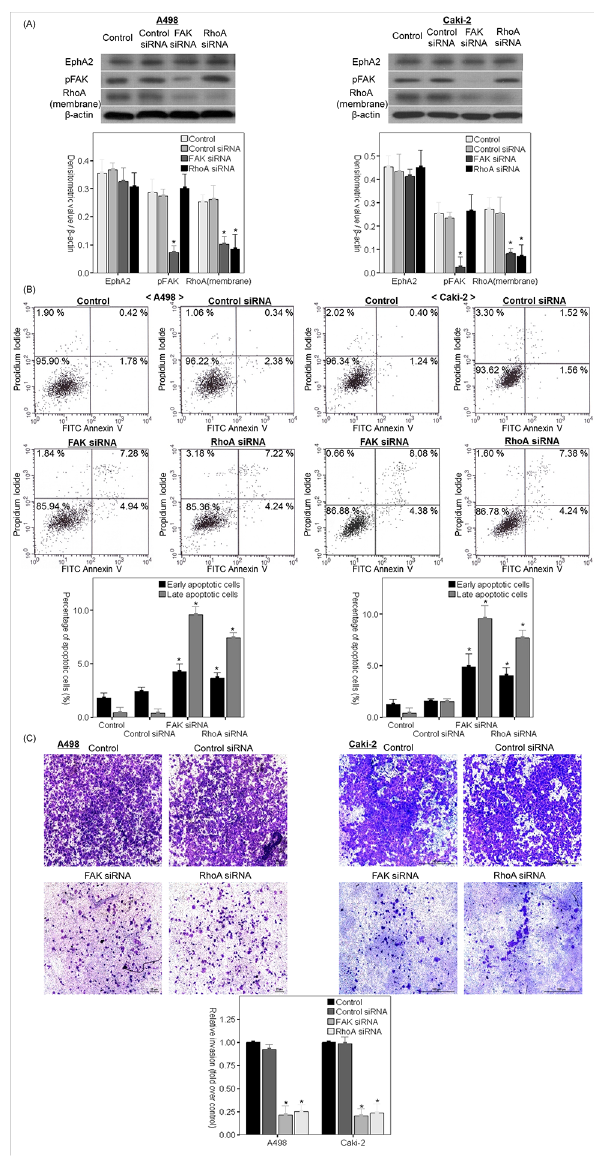
Fig 8. Effect of FAK/RhoA siRNA on malignant cellular behavior and EphA2 expression in non- metastatic RCC cells. (A) Representative immunoblots and comparisons of protein expression of EphA2, pFAK, membrane-bound RhoA and β -actin among untreated cell s (control), control siRNA treated cell s and FAK or RhoA siRNA treated cell s at 48 hours after treatment in each cell line. (B) Determination of the percentage of early or late apoptotic cells relative to the total number of cells following FAK or RhoA siRNA treatment in each cell line. (C) Effect of FAK and RhoA siRNA on cellular invasiveness in each cell line. * p < 0.05 vs. control and control siRNA treated groups. siRNA = small interfering RNA, FAK = focal adhesion kinase, pFAK = phosphorylated focal adhesion kinase, RCC = renal cell